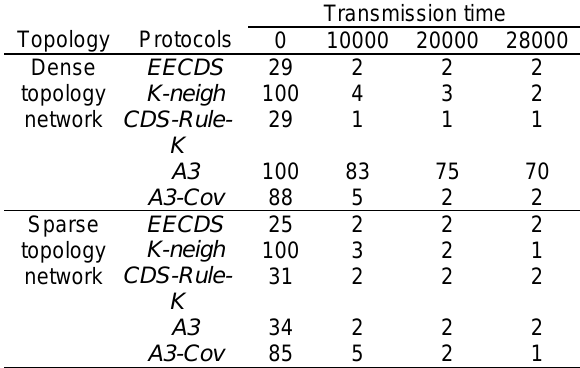
Table 6. Experiment 2: Number of active nodes reachable from sink